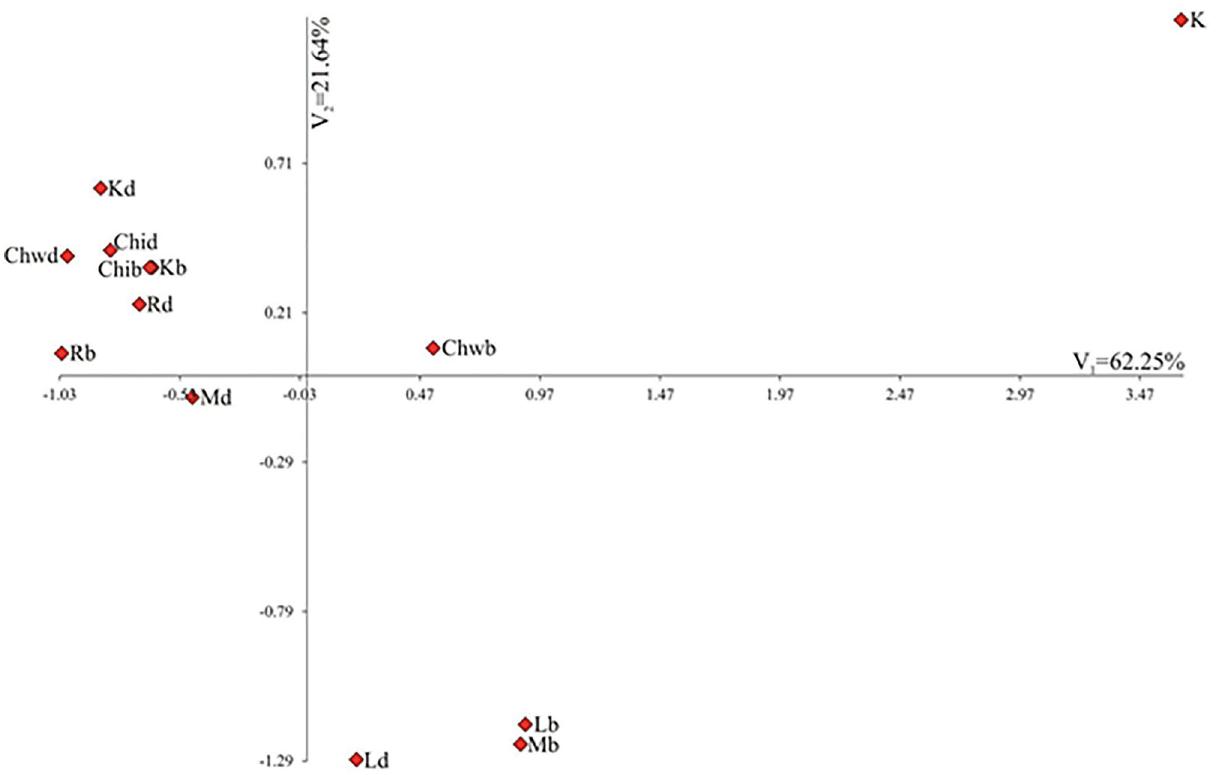
Figure 6. Distribution of combinations of herbicides and application methods in the space of the first canonical variable (V 1 ) and the second canonical variable (V 2 ). Combinations: K – trees without any treatment, Kd – trees with drilling, Kb – trees with bark incision as well as five different herbicides: Chi – Chikara, Chw – Chwastox,